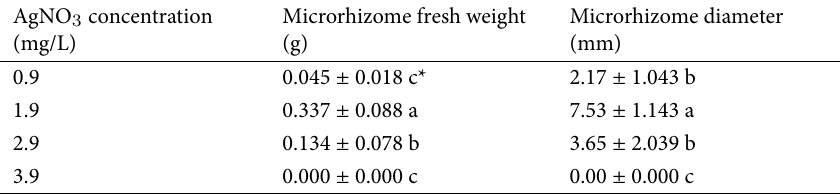
Table 2 Effect of silver nitrate (AgNO 3 ) concentrations on microrhizome